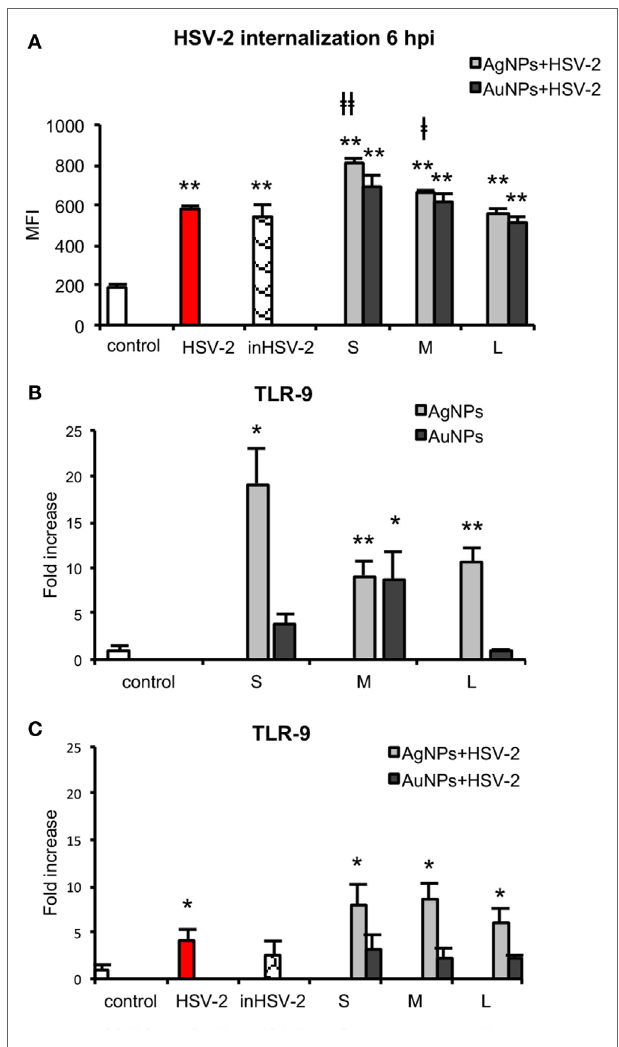
FigUre 8 | Nanoparticles (NPs) stimulate uptake of viral antigens and expression of TLR9. (a) Presence of HSV-2 antigens in JAWS II cells after 6 h exposure to HSV-2, inactivated HSV-2, or NPs-treated HSV-2. TLR 9 expression in NPs- and HSV-NPs-treated JAWS II cells. The cells were exposed to 2.5 µg/ml of (b) TA-Ag/AuNP, (c) TA-AgNPs or TA-AuNPs- treated HSV-2. Each bar represents the mean from three experiments ( N = 3) ± S.E.M. *Significant differences with p ≤ 0.05, ** p ≤ 0.01 in relation to untreated control, ǂ p ≤ 0.05, and ǂǂ p ≤ 0.01 calculated in relation to the HSV-2 infected